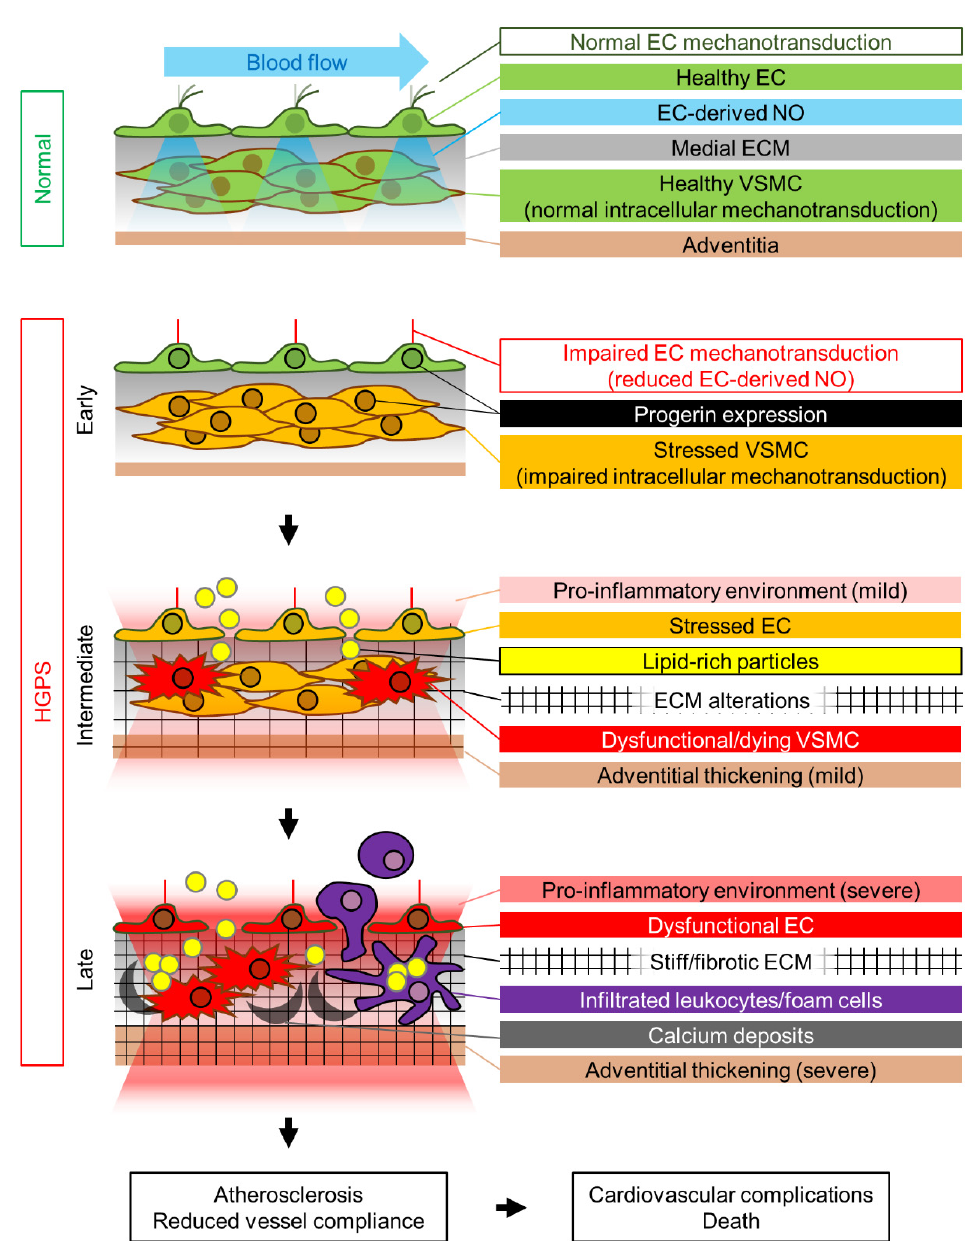
Figure 1. Proposed mechanism of HGPS-associated cardiovascular dysfunction. Progerin expression is represented by a black nuclear rim. EC, endothelial cell; ECM, extracellular matrix; NO, nitric oxide; VSMC, vascular smooth muscle cell.